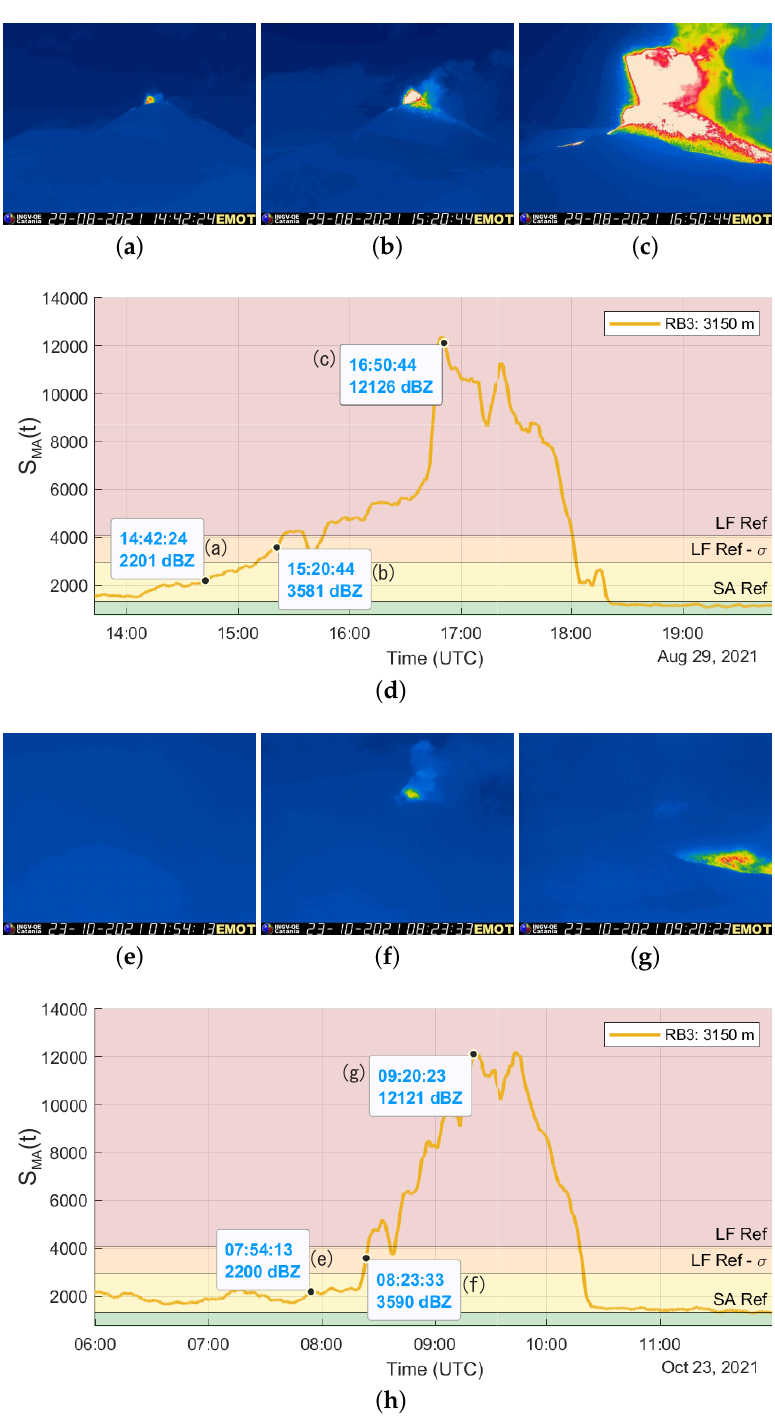
Figure 7. Thermal images from the EMOT (Etna MOntagnola Termica) thermal camera and time series of two eruptive episodes recorded under different weather conditions: sunny ( a – d ) and strongly cloudy ( e – h ) weather. The times at which the images were acquired are identified by dots on the time series. Despite the poor visibility shown in ( e – g ), our system perfectly records the entire eruptive episode ( h